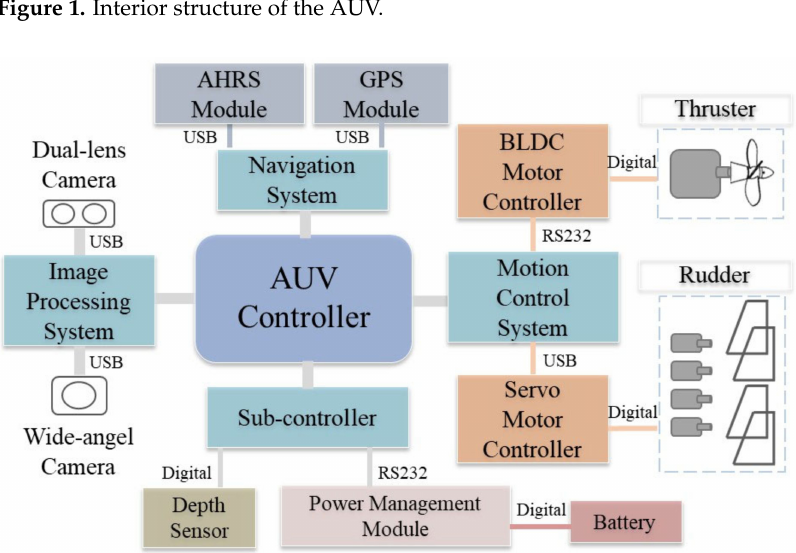
Figure 2. The system architecture of the